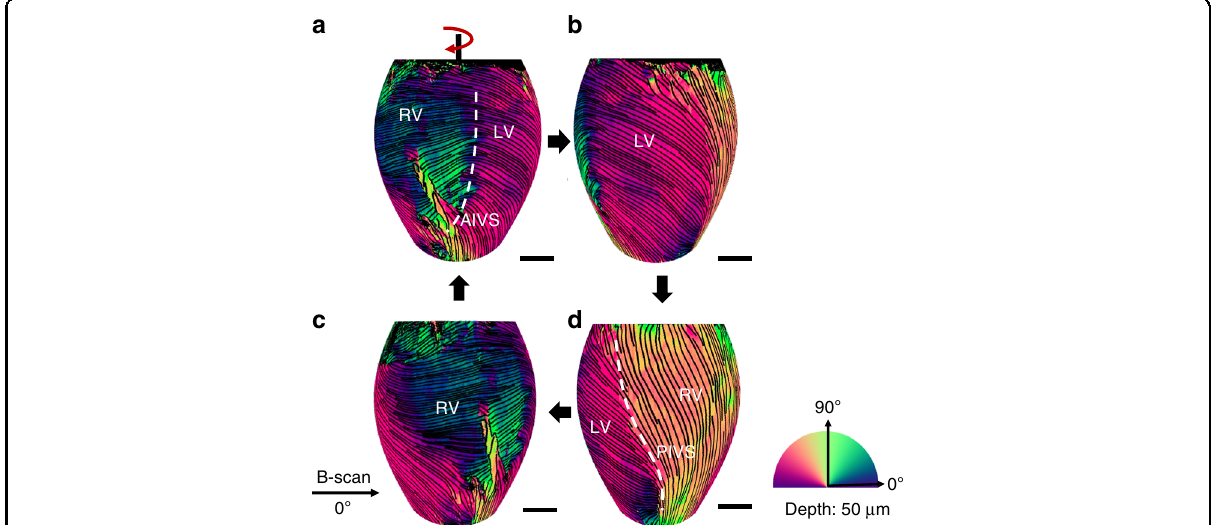
Fig. 1 Myocardial fi ber orientation mapping of a whole mouse heart. With the proposed DDG-based PST method, single input PSOCT is capable of providing the orientation information of myocardial fi ber within super fi cial ventricular wall of a whole mouse heart. Results shown are different perspective views of a reconstructed 3D optic axis orientation map at 50 μ m below the heart surface of a whole heart (Supplementary Section S3). a The front view; b The right-side view to show left ventricle; c The left-side view to show right ventricle; d The back view of the 3D volume-rendered myocardial fi ber organizations in the whole heart. The colormap is shown in the lower right corner. The streamlines on the heart represent the orientation of the myo fi bers. In the lower left corner, the black arrow indicates the B-scan direction, which is de fi ned as the 0°. The scale bar = 1 mm. RV right ventricle, LV left ventricle, AIVS anterior interventricular sulcus, and PIVS posterior interventricular